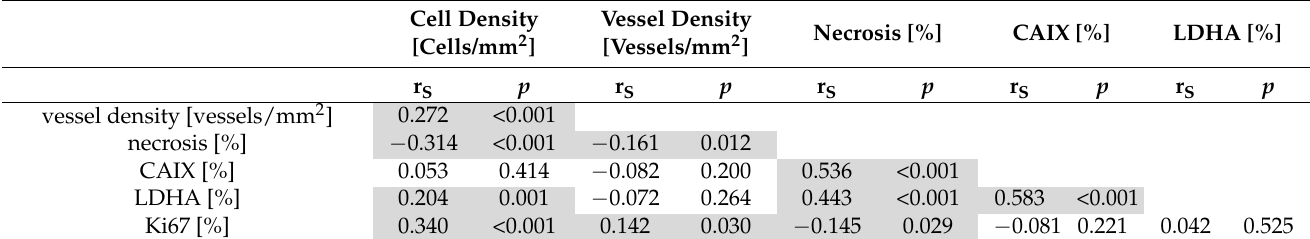
Table 4. Correlations between histopathological features. Significant correlations are highlighted in grey. r S = Spearman correlation coefficient, p = p -value. For glioblastoma samples only, see Supplementary Table